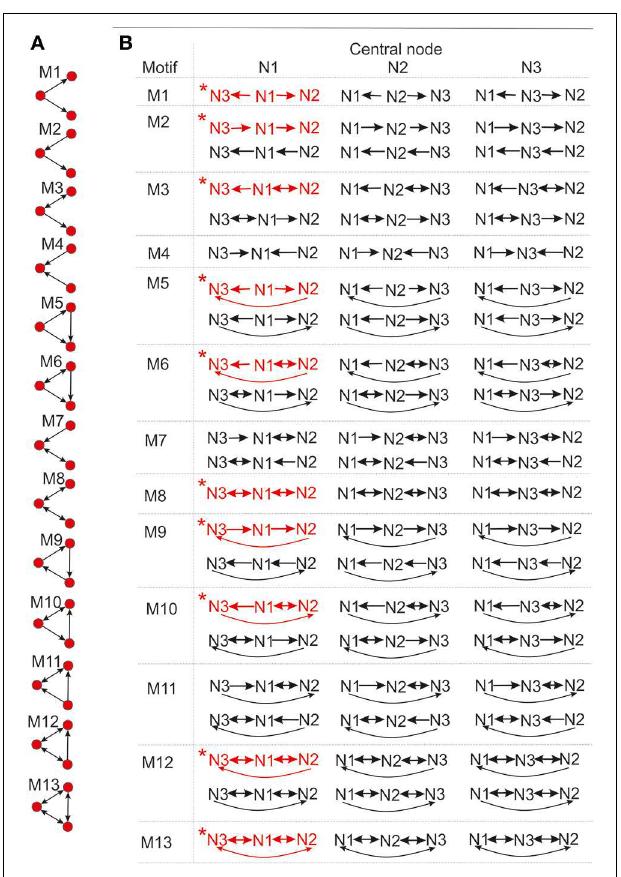
FIGURE 3 | The schematic representation of all possible 3-node motifs. (A) The standard representation of motifs ( Milo et al., 2002). (B) All the possible connectivity patterns between the three (fixed) nodes. Columns 1,2,3 in the table correspond to the nodes N 1 , N 2 , N 3 being the central node in the connectivity pattern. The complete list of 3-node connectivity patterns can be reduced to the 10 representative patterns (highlighted in red), and only these 10 patterns are considered in computations of the expected motif